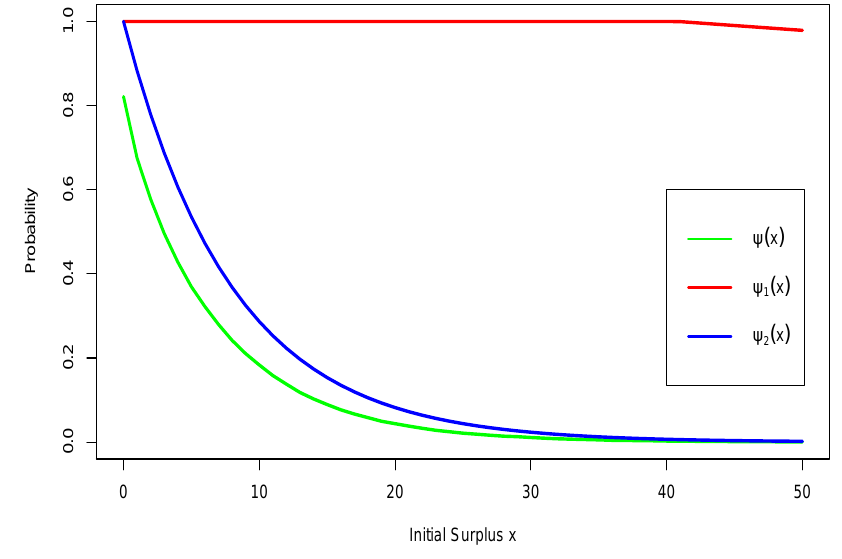
Figure 2. Ruin probability for model of Example